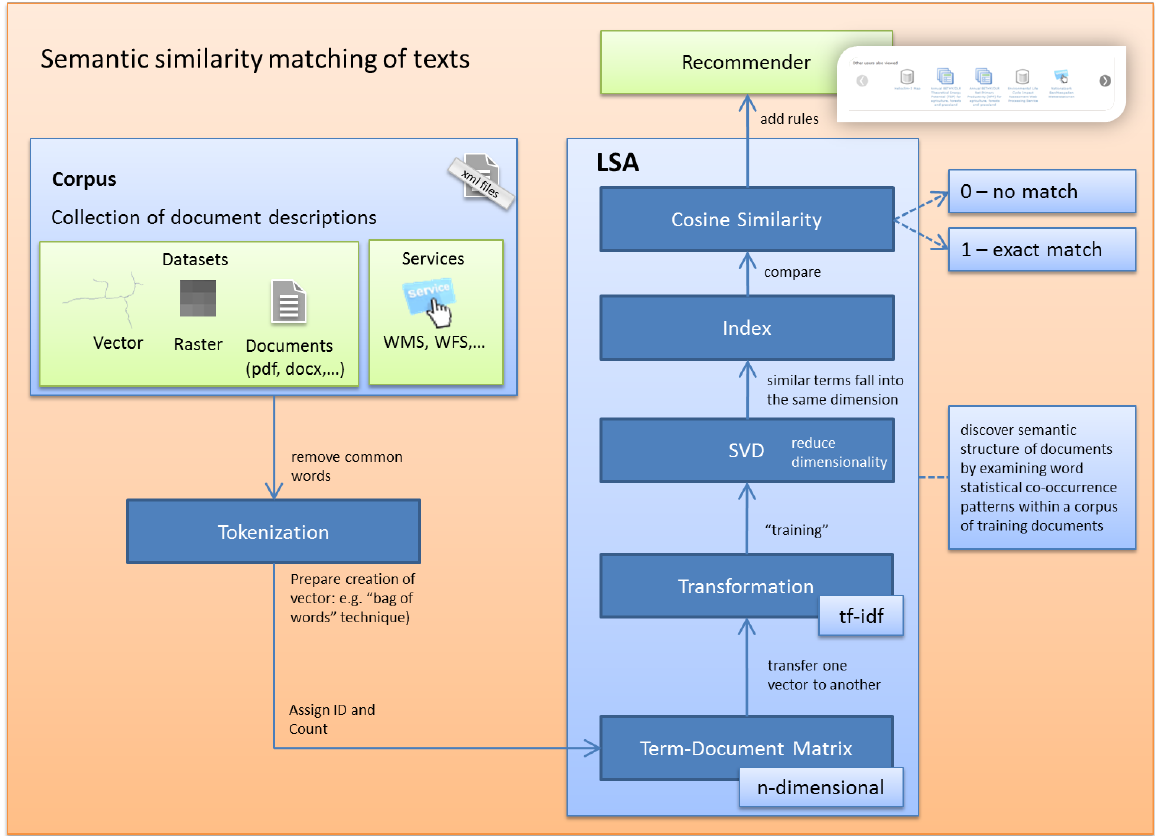
Figure 7. Workflow of semantic similarity matching of